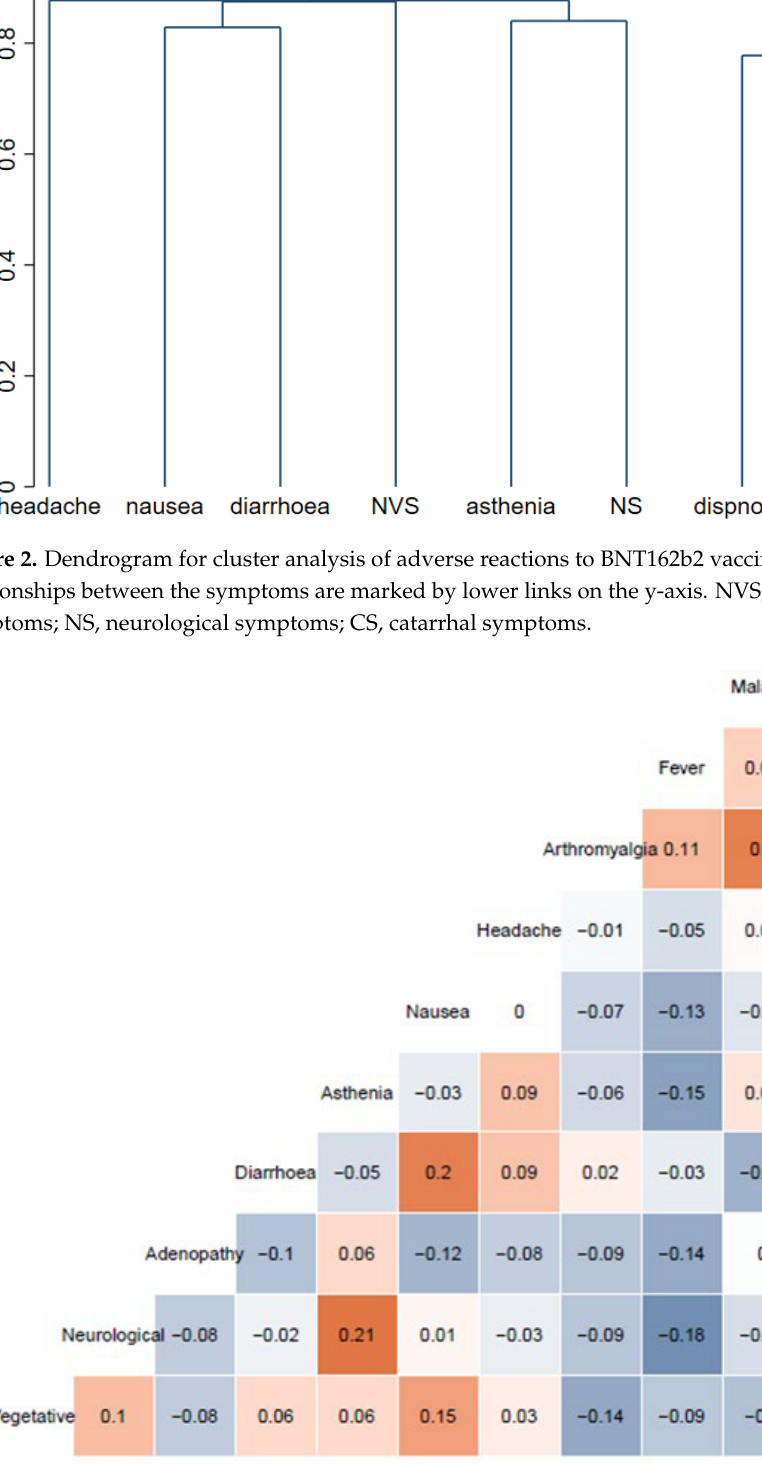
Figure 3. Correlation map of the associations between individual adverse reactions. Only the 10 most frequent reactions are represented. Malaise, general malaise; adenopathy, painful adenopathy; vegetative, neurovegetative symptoms.